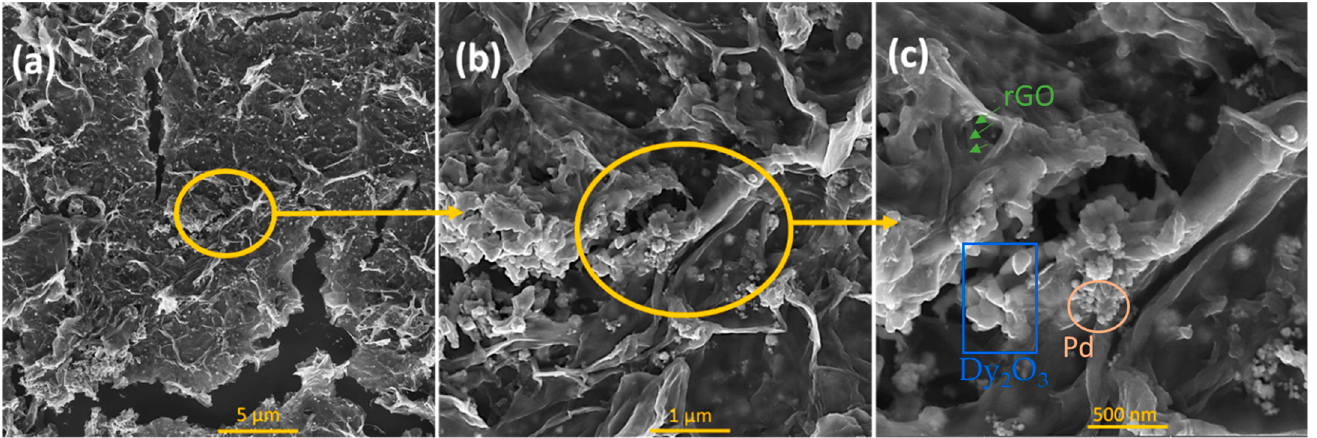
2 O 3 -Pd-PDA/rGO nanocomposite.